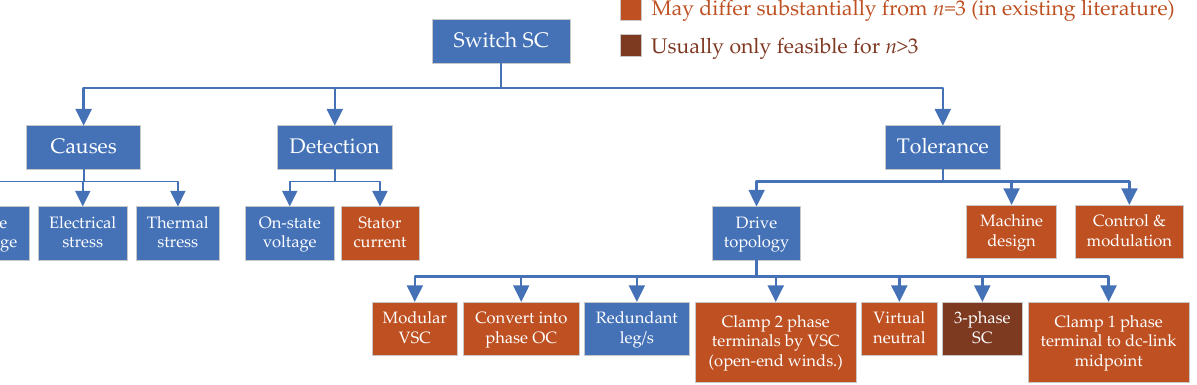
Figure 14. Causes, detection methods, and tolerance approaches for switch SC faults in multi- phase